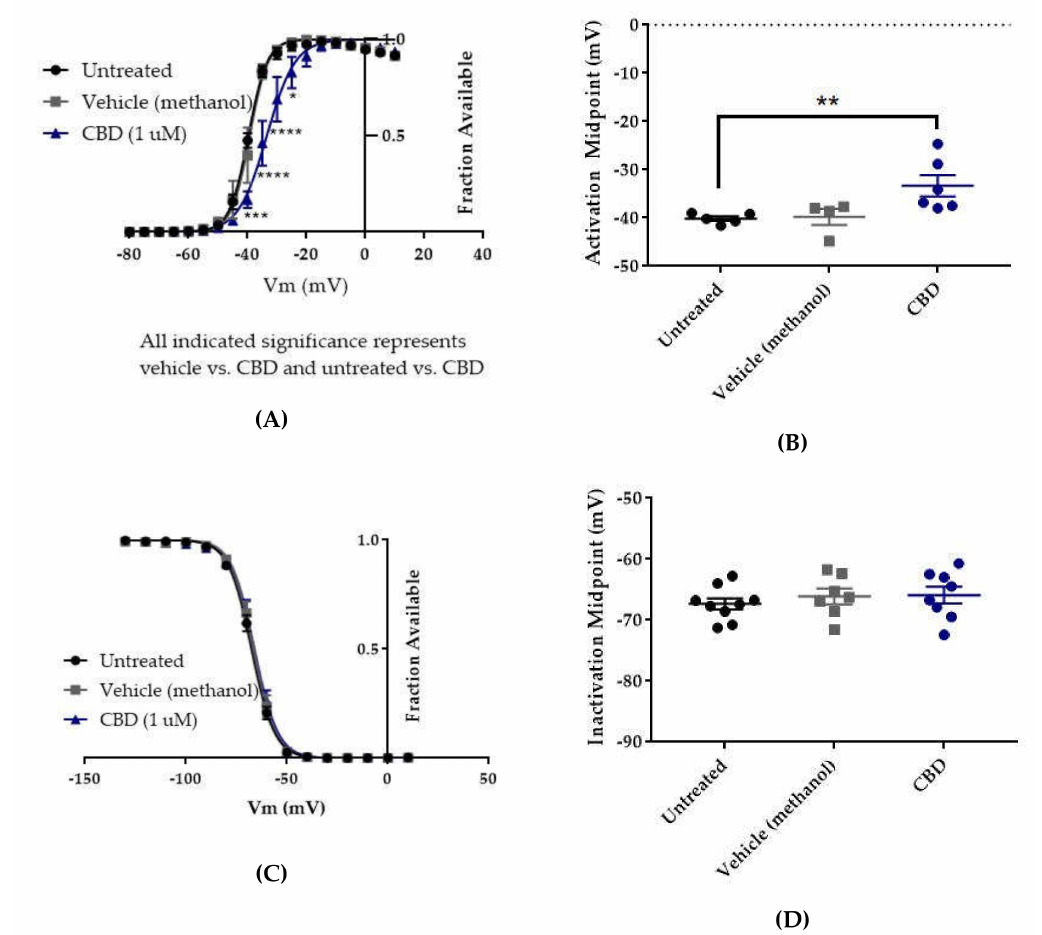
Figure 7. E ff ects of CBD on WT hNav1.2 gating in stable HEK cell lines. Unless otherwise indicated, * p < 0.05, ** p < 0.01, *** p < 0.001, **** p < 0.0001. ( A ) Activation curves. Conductance was calculated